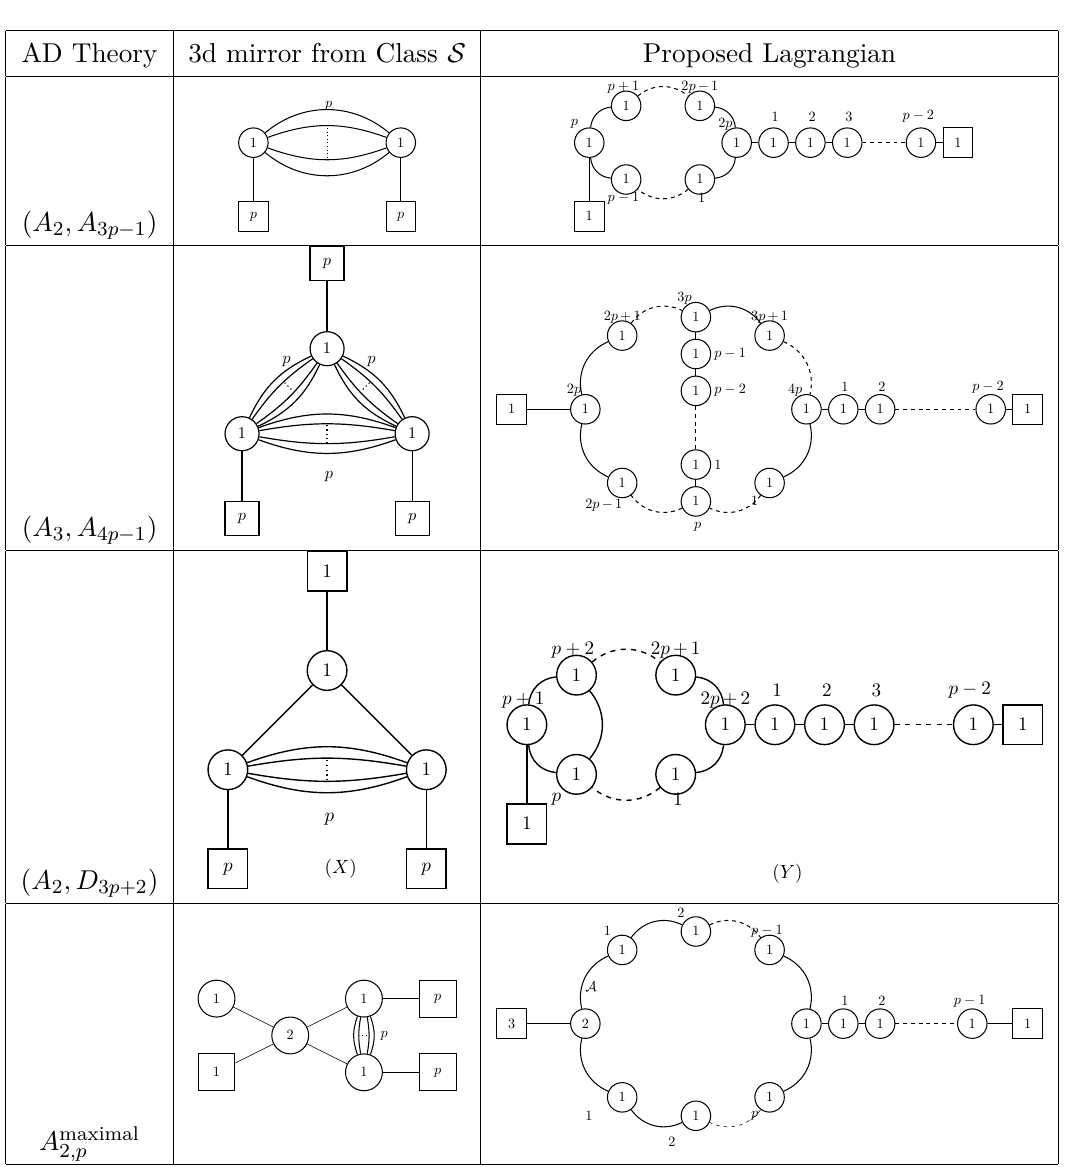
Table 2 . Summary table of 3d mirror pairs associated with certain Argyres-Douglas theories realized in the class S construction. The third column tabulates the proposed Lagrangians for the 3d SCFTs obtained by putting the Argyres-Douglas theory on a circle and flowing to the deep IR. The theory labelled A maximal in the fourth row is an AD theory realized by the twisted 2 ,p compactification of a 6d (2,0) A theory on a Riemann sphere with an irregular puncture and a 2 maximal regular